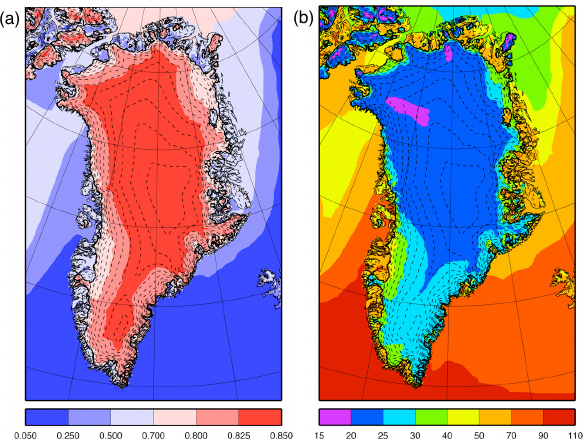
Fig. 9. Annual mean (a) total cloud cover [ − ], and (b) atmospheric SW transmissivity (SW ↓ /SW ↓ , TOA ) [ −